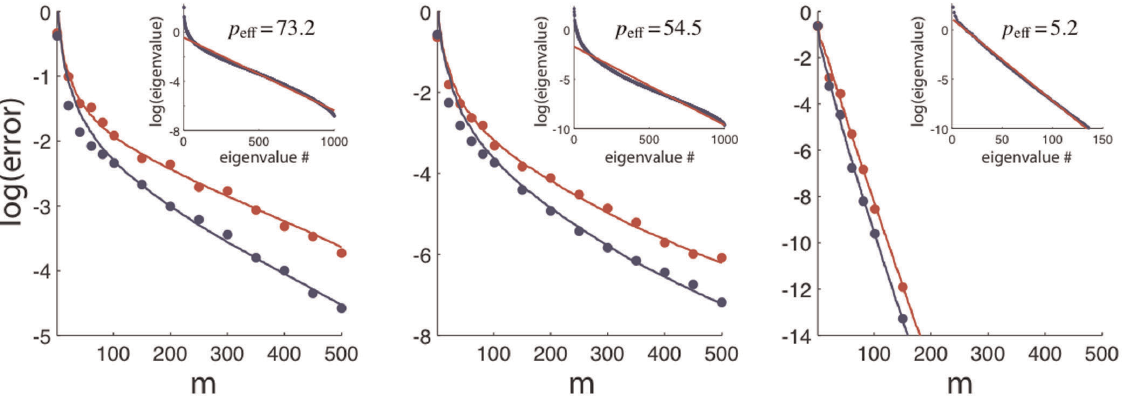
Figure 2. Comparison of network simulations and analytical results. The network simulations (filled circles) and analytic results (solid lines) for sparse (red) and PC (blue) reconstruction errors as a function of m for different p eff values. The ‘‘error’’ here is either S ( z sparse ( t ) { z ( t )) 2 T (red points and curve) or S ( z PC ( t ) { z ( t )) 2 T (blue points and curve). The input was I ( t ) ~ c (sin( pv t ) z sin(2 pv t ) = 2 z sin(3 pv t ) = 6 z sin(4 pv t ) = 3) with v ~ 1 = (60 t ) and c =0, 0.4, 0.6 in the three panels, from left to right. The value of p eff was adjusted by changing c . Inserts show the PC eigenvalues (blue) and the exponential fits to them (red), using the value of p eff indicated. Logarithms are base 10.